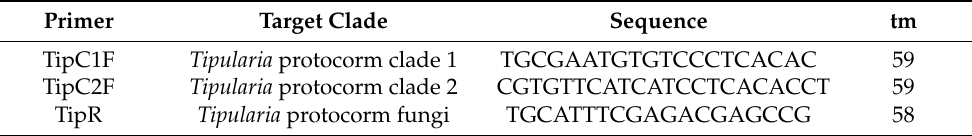
Table 1. PCR primers used in this study. TipR is the reverse primer for both forward primers. Reference for all is McCormick et al.